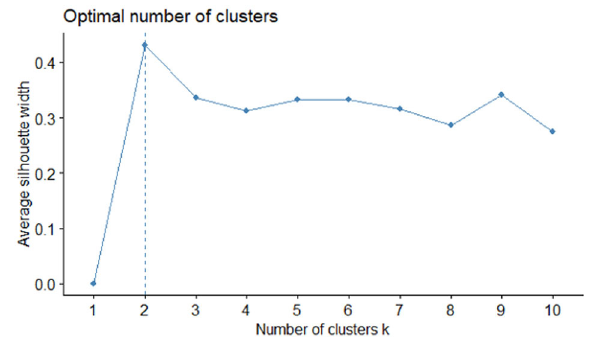
Fig. 8 Average silhouette width.